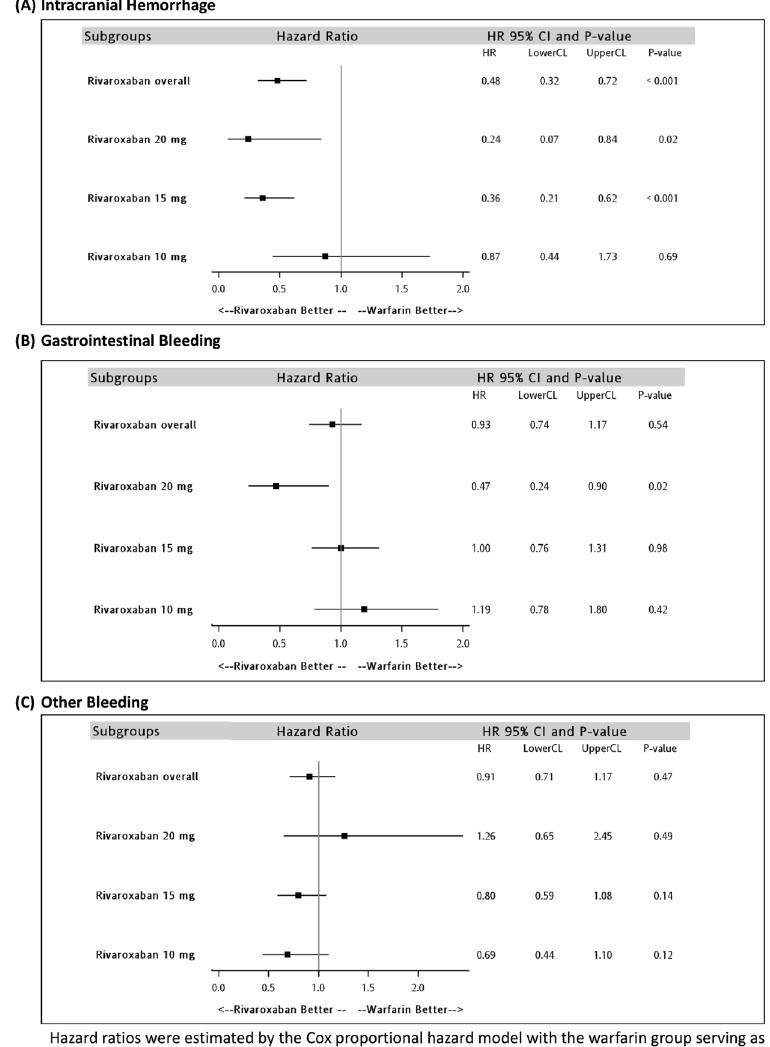
Figure 2. Comparisons of the safety outcomes among different dose regimens in the rivaroxaban group.